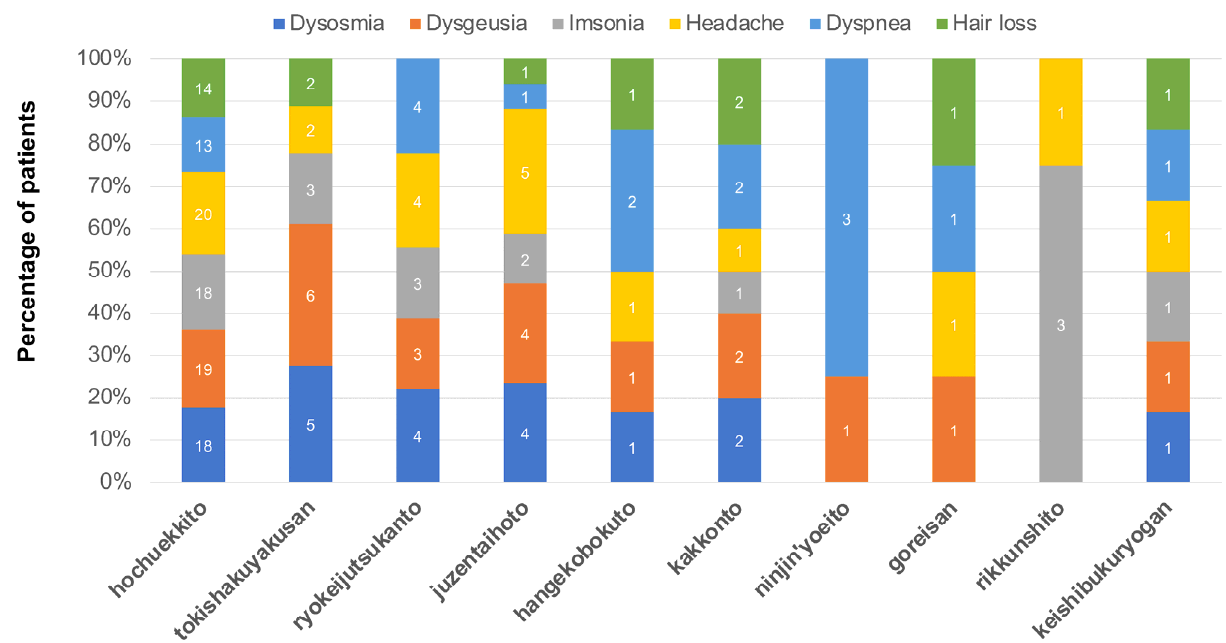
Figure 3. Frequencies of Kampo medicines prescribed for symptoms accompanying general fatigue.